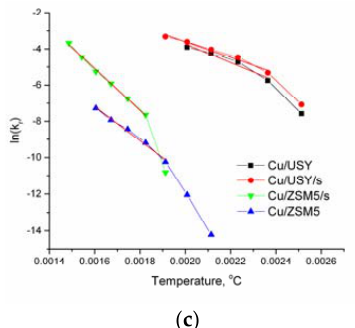
Figure 1. Kinetic results of selective catalytic reduction (SCR) deNO x over various zeolite catalysts: ( a ) reaction rate; ( b ) N 2 selectivity in SCR of NO with NH 3 ; ( c ) Arrhenius plot based on kinetic results presented in ( a ).